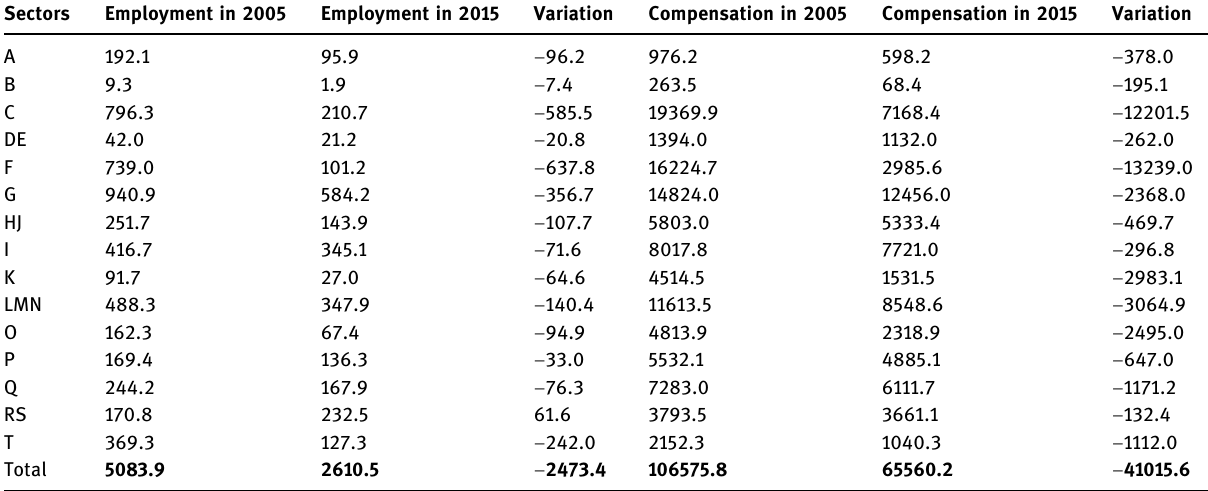
Table 4: Variation in employment and compensation of young employees aged 16 – 29 per productive sector in the 2005 − 2015 period ( stated in thousands of jobs and millions of euros ) Sectors